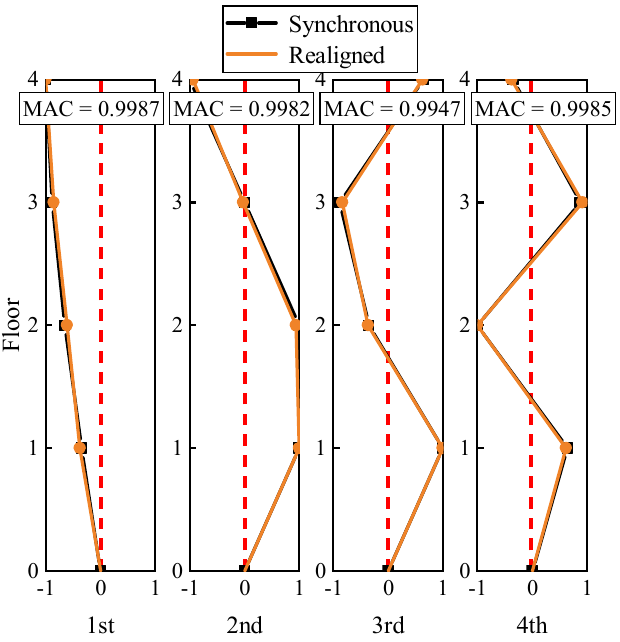
Figure 8. Mode shapes of lateral bending modes in synchronous and realigned.